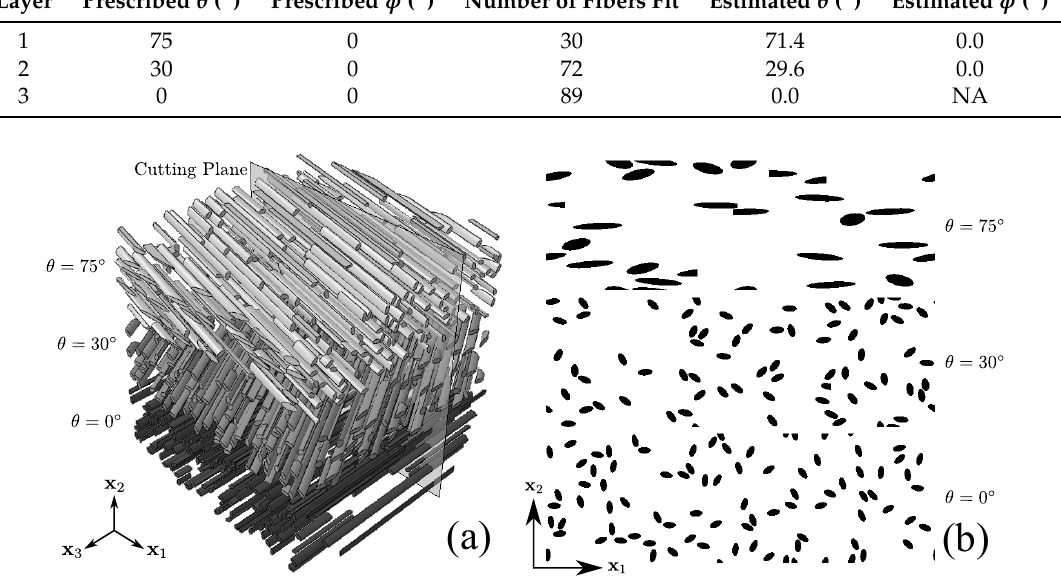
Figure 11. Synthetic micrograph from generated volume of fibers: ( a ) full 3D volume and viewing plane; and ( b ) resulting synthetic micrograph.